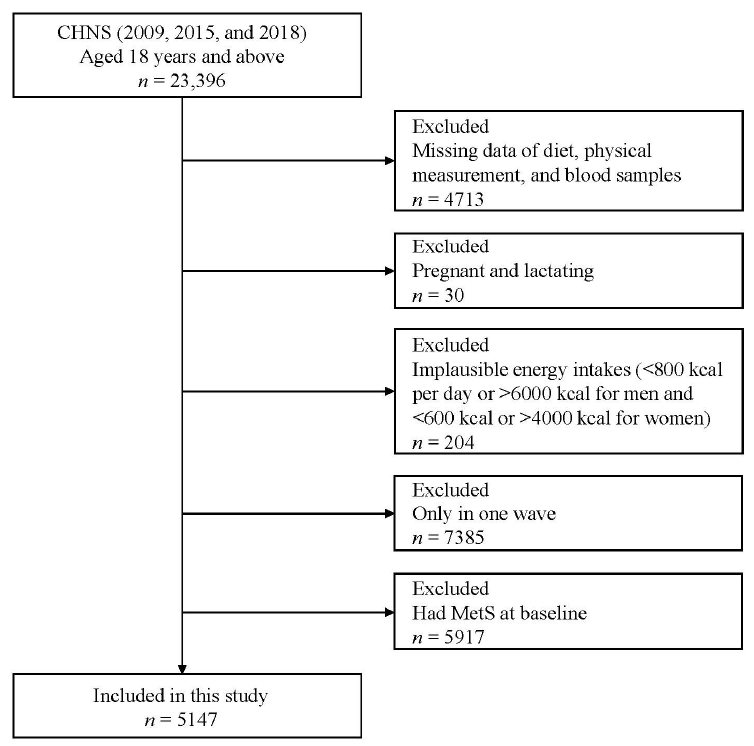
Figure 1. Flowchart of the participants included in this study.